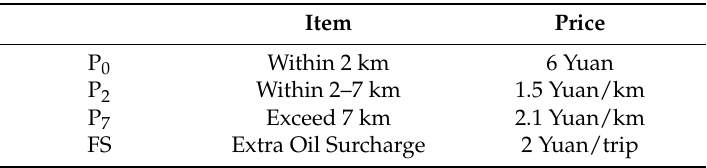
Table 3. Taxi fare system of Wuhan City in 2013.